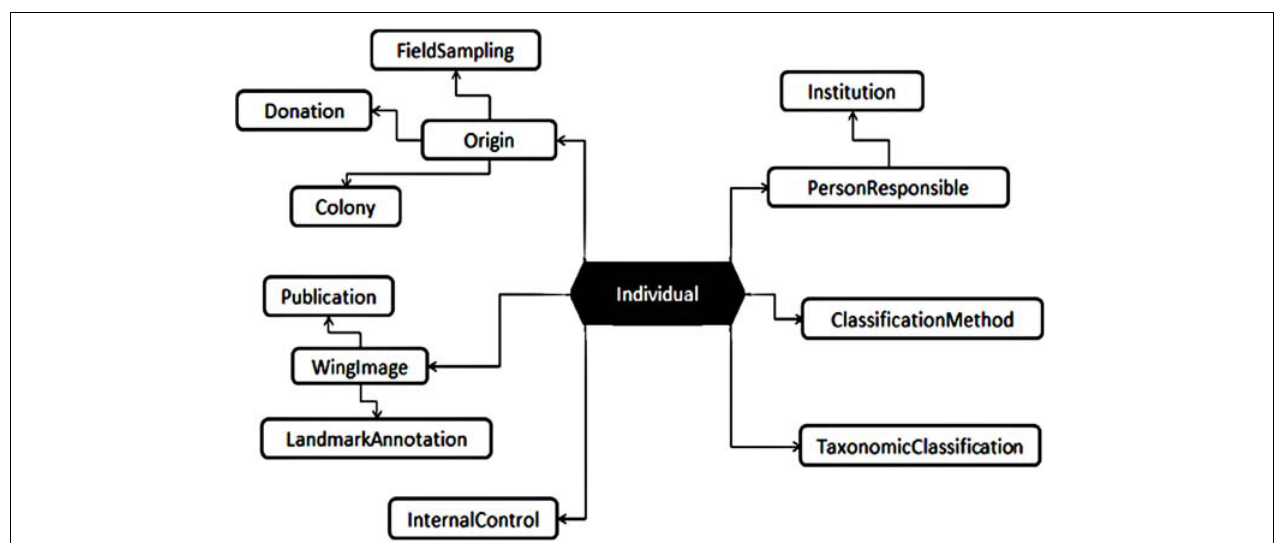
FIGURE 1 | WingBank database conceptual